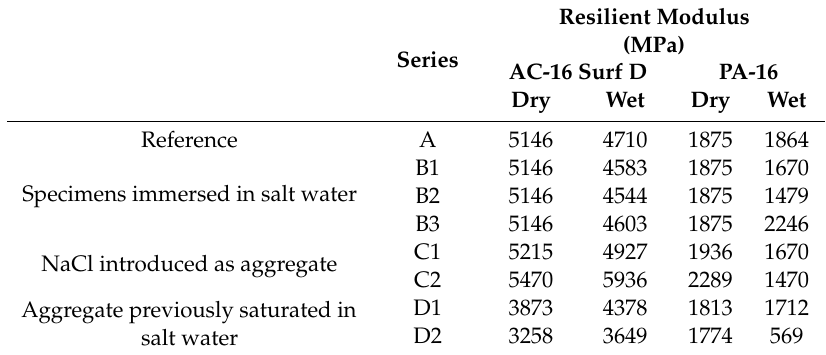
Table 1. Resilient modulus.